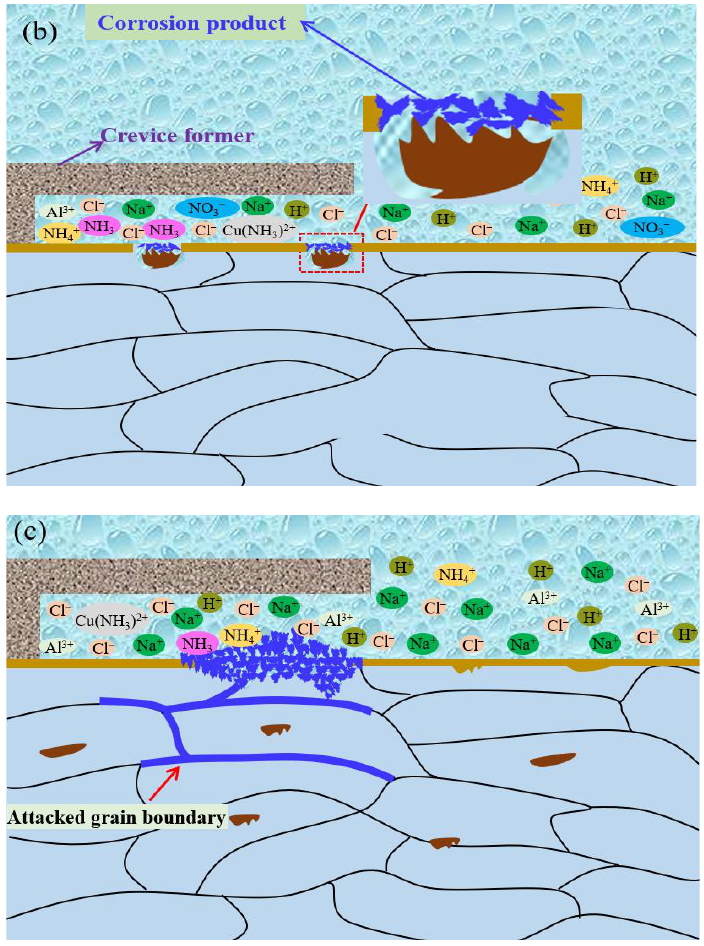
Figure 12. The crevice corrosion mechanism of the 7075-T651 aluminium alloy in acidic NaCl with NaNO 3 , ( a ) the induction period, ( b ) the quick development period, ( c ) the stable development period